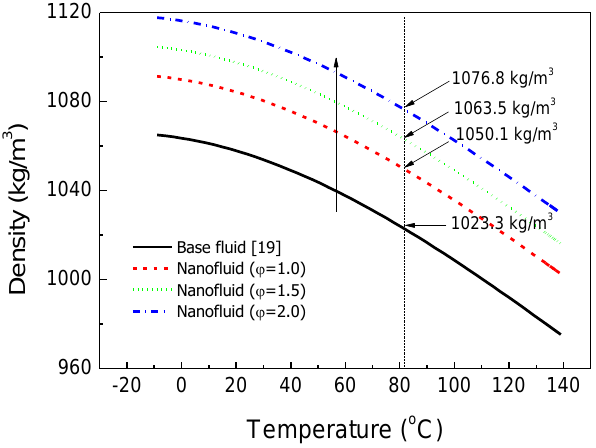
Figure 5. Density modeling of the base fluid and Al 2 O 3 nanofluids.